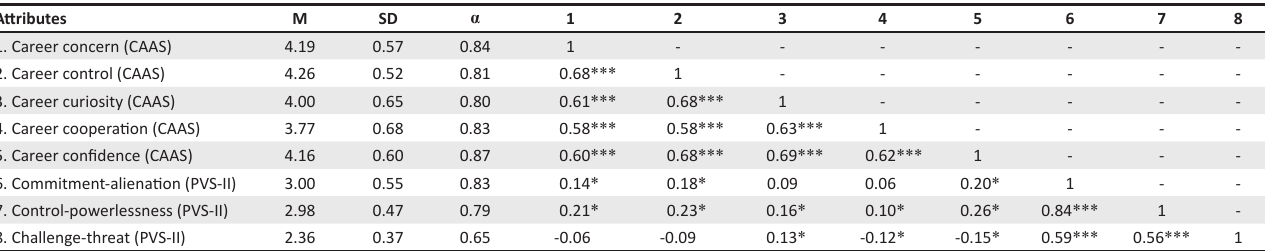
TABLE 2: Means, standard deviations, reliabilities and bivariate correlations: Resiliency-related behavioural capacities . Attributes M SD